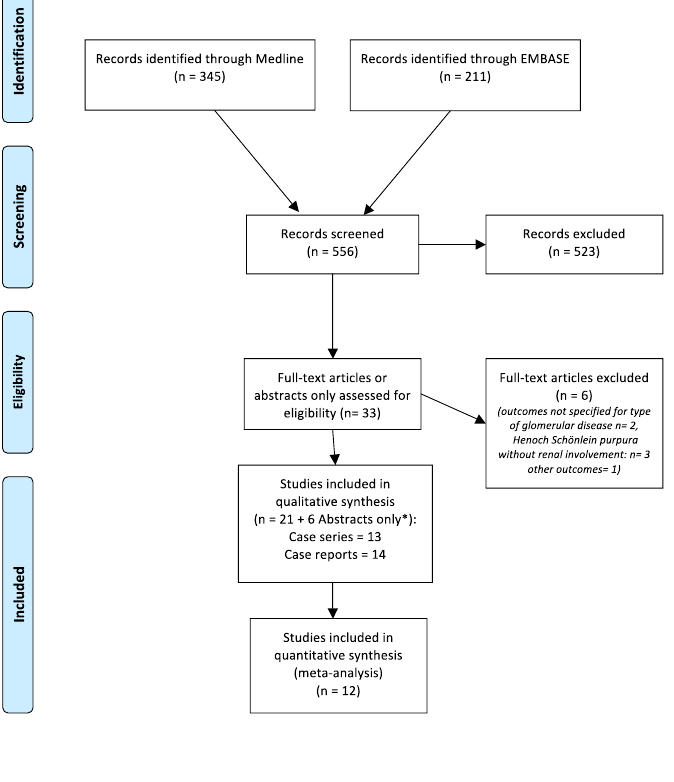
Figure 1. The flow-chart of the retrieved papers.